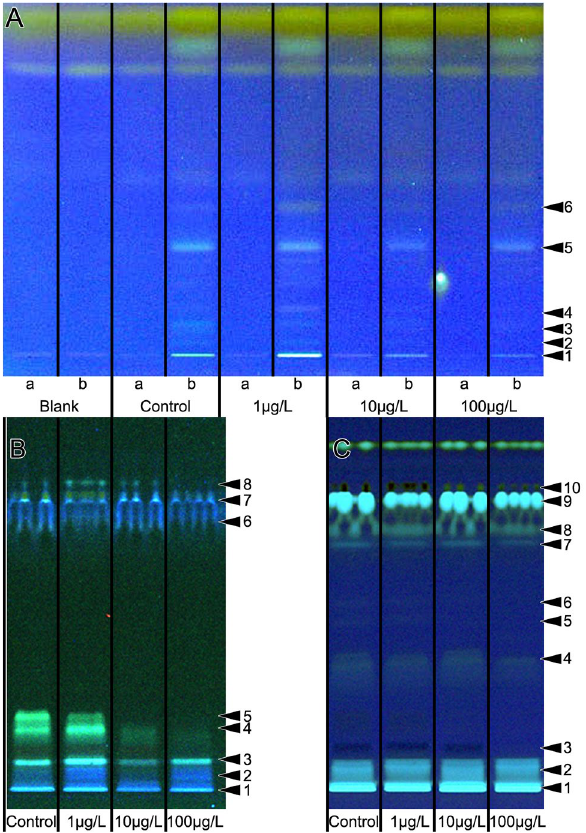
Figure 2. Lipid profiles of worker jelly samples ( A ) and larvae ( B , C ) from week 3. Samples of worker jelly ( A ) were taken using absorptive filter strips (Sugi strips), extracted with n -hexane and separated by HPTLC. Each Sugi strip was halved: one half without the sample (track a) and the other with absorbed sample (track b). A fresh Sugi strip from the same batch as the strips used in the experiment cut in two equal halves served as the blank. The lanes are labeled to show the dose of clothianidin treatments (control = no clothianidin). The analysis of larvae is shown before ( B ) and after derivatisation ( C ). For worker jelly, the declining quantity of substances was observed for the lipid profiling (UV 366 nm after derivatization). The latter also was evident for the larvae. Numbers on the right side indicate differences, see SFig 3B, F and